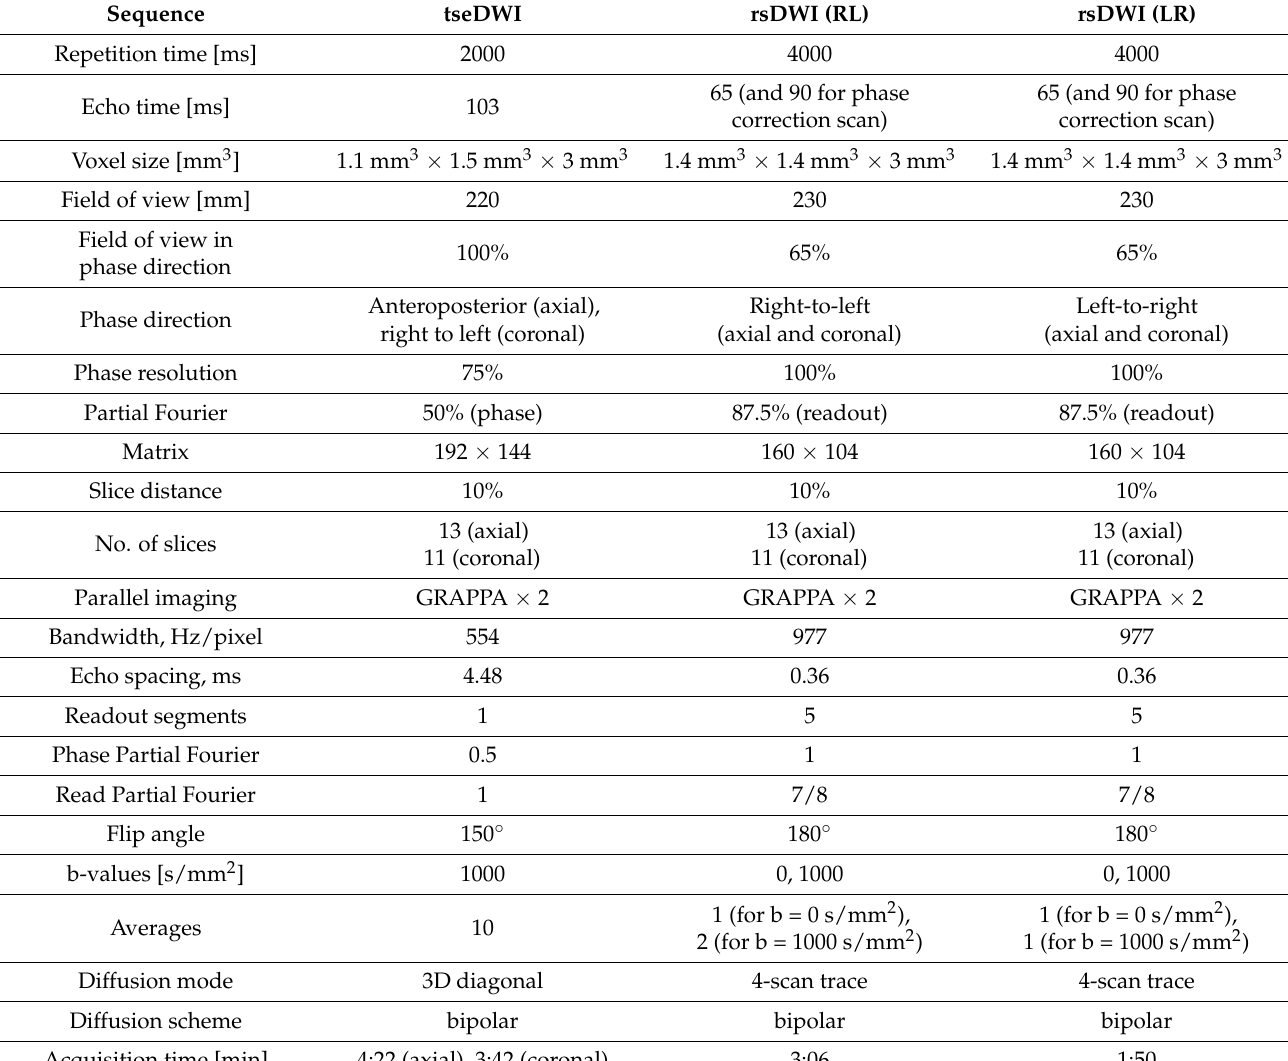
Table 1. DWI sequence